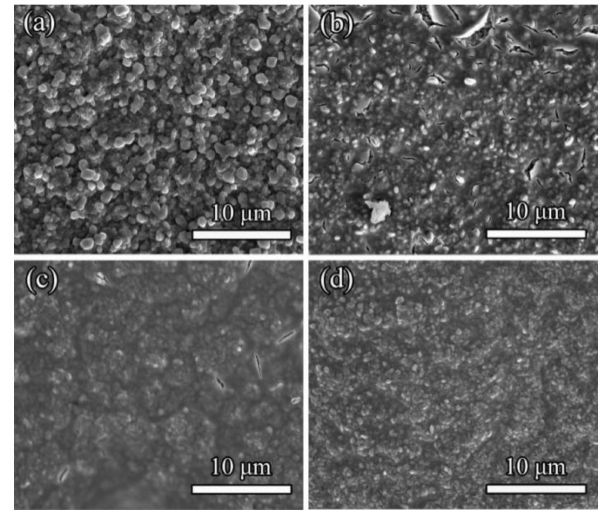
Figure 3. SEM images of the ( a ) unsealed and ( b – d ) sealed Cr 2 O 3 coatings heat-treated at different